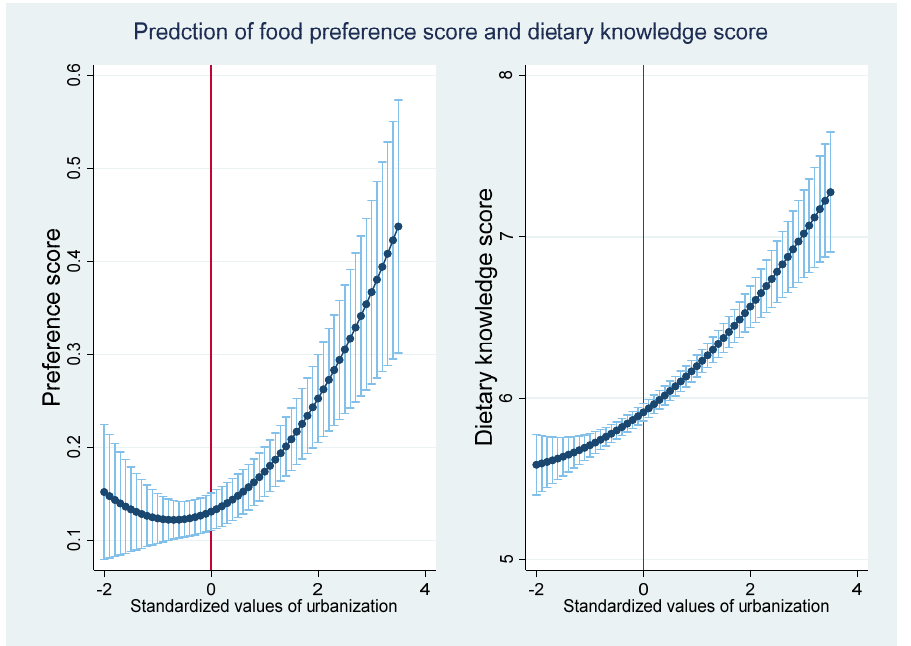
Figure 6. The relationship between urbanization and the predicted food preference and dietary